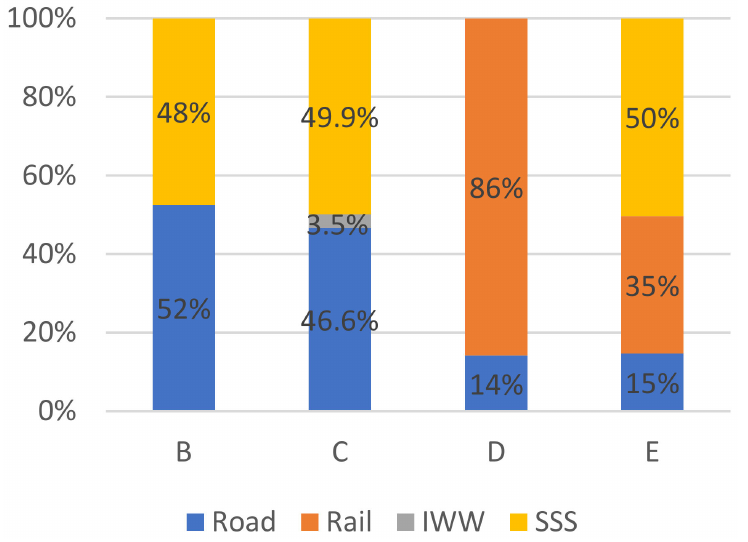
Figure 4. Share of external cost per transport mode in the intermodal chains between Porto and Stuttgart.